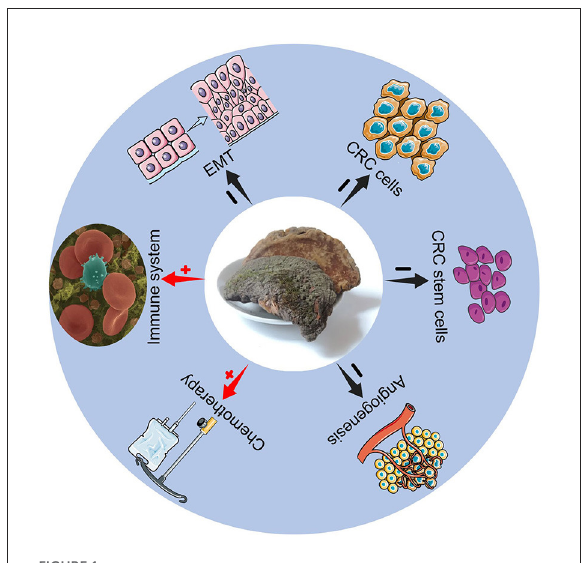
FIGURE1 Mechanisms of Trametes Robiniophila Murr for CRC treatment.